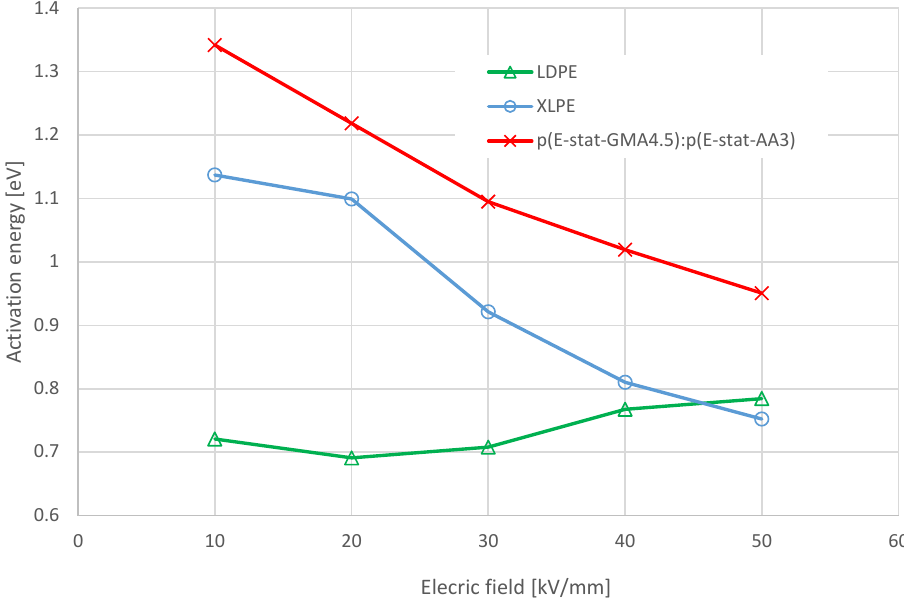
Figure 7. Electric field dependence of activation energy.